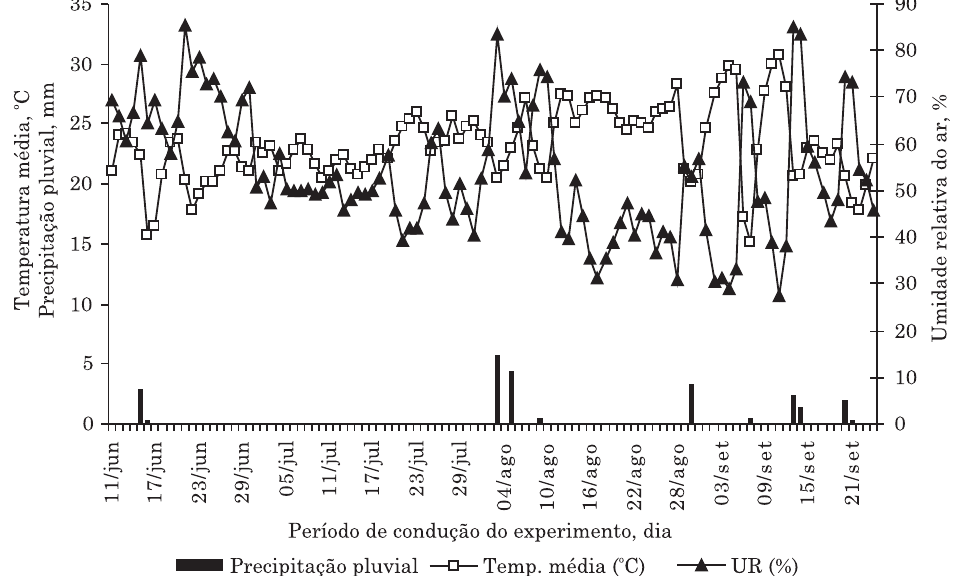
Figura 1. Precipitação pluvial, temperatura média e umidade relativa do ar, durante a condução do